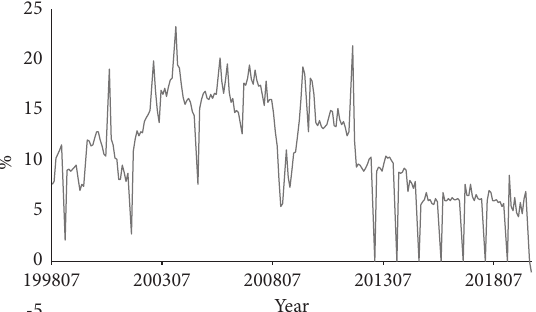
Figure 2: Historical data chart of China’s industrial value-added growth